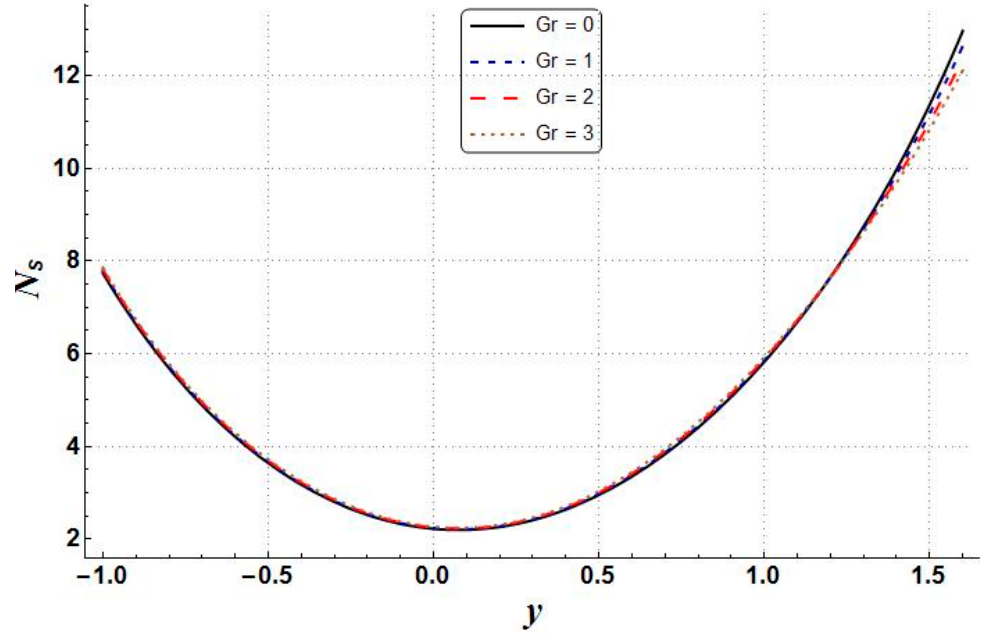
N through changing values of